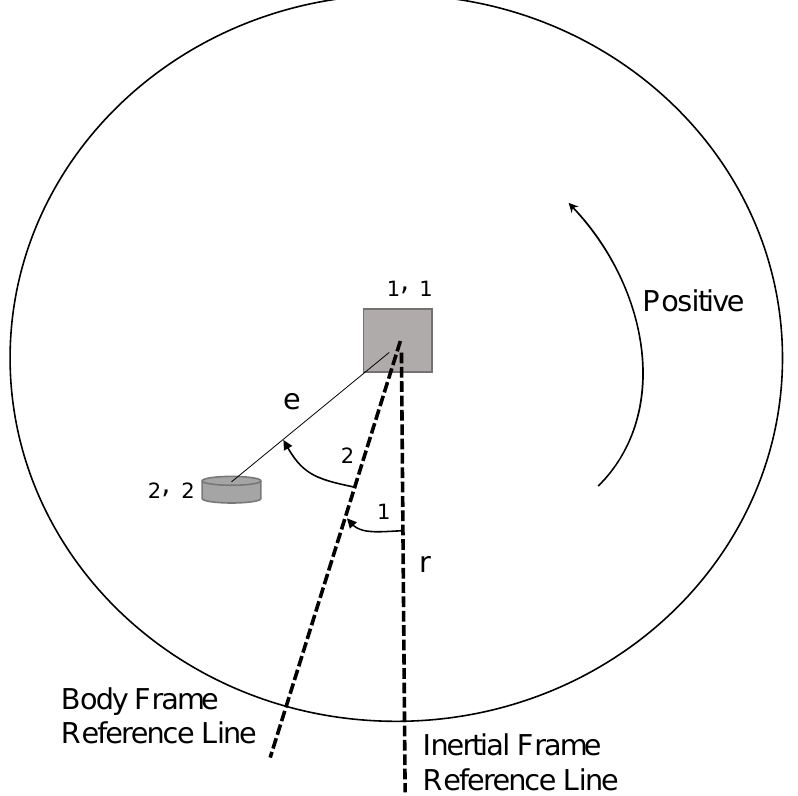
Figure 3. Simplified scheme of the horizontal movement of the robot (1 rotation angle of the ball, 2 rotation angle of the pendulum with respect to the